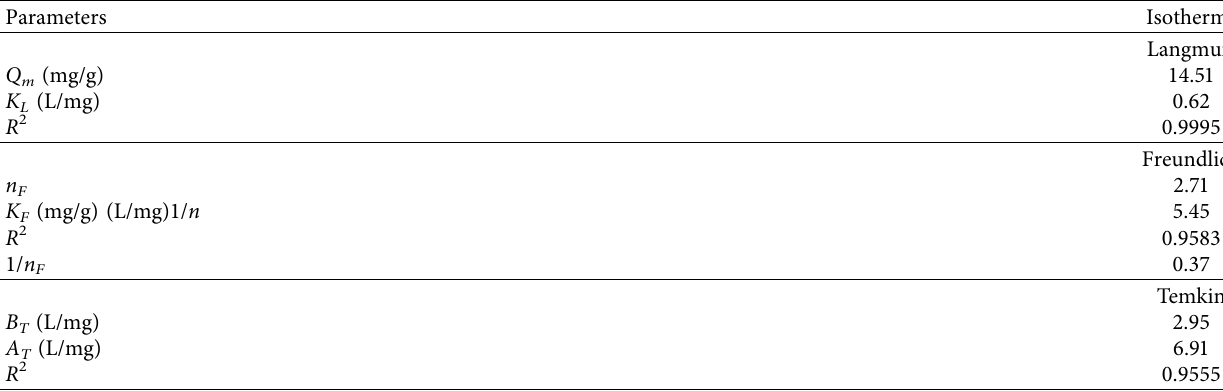
Table 6: Isotherm parameters for adsorption of adsorbates onto CSAC at 30 ° C.